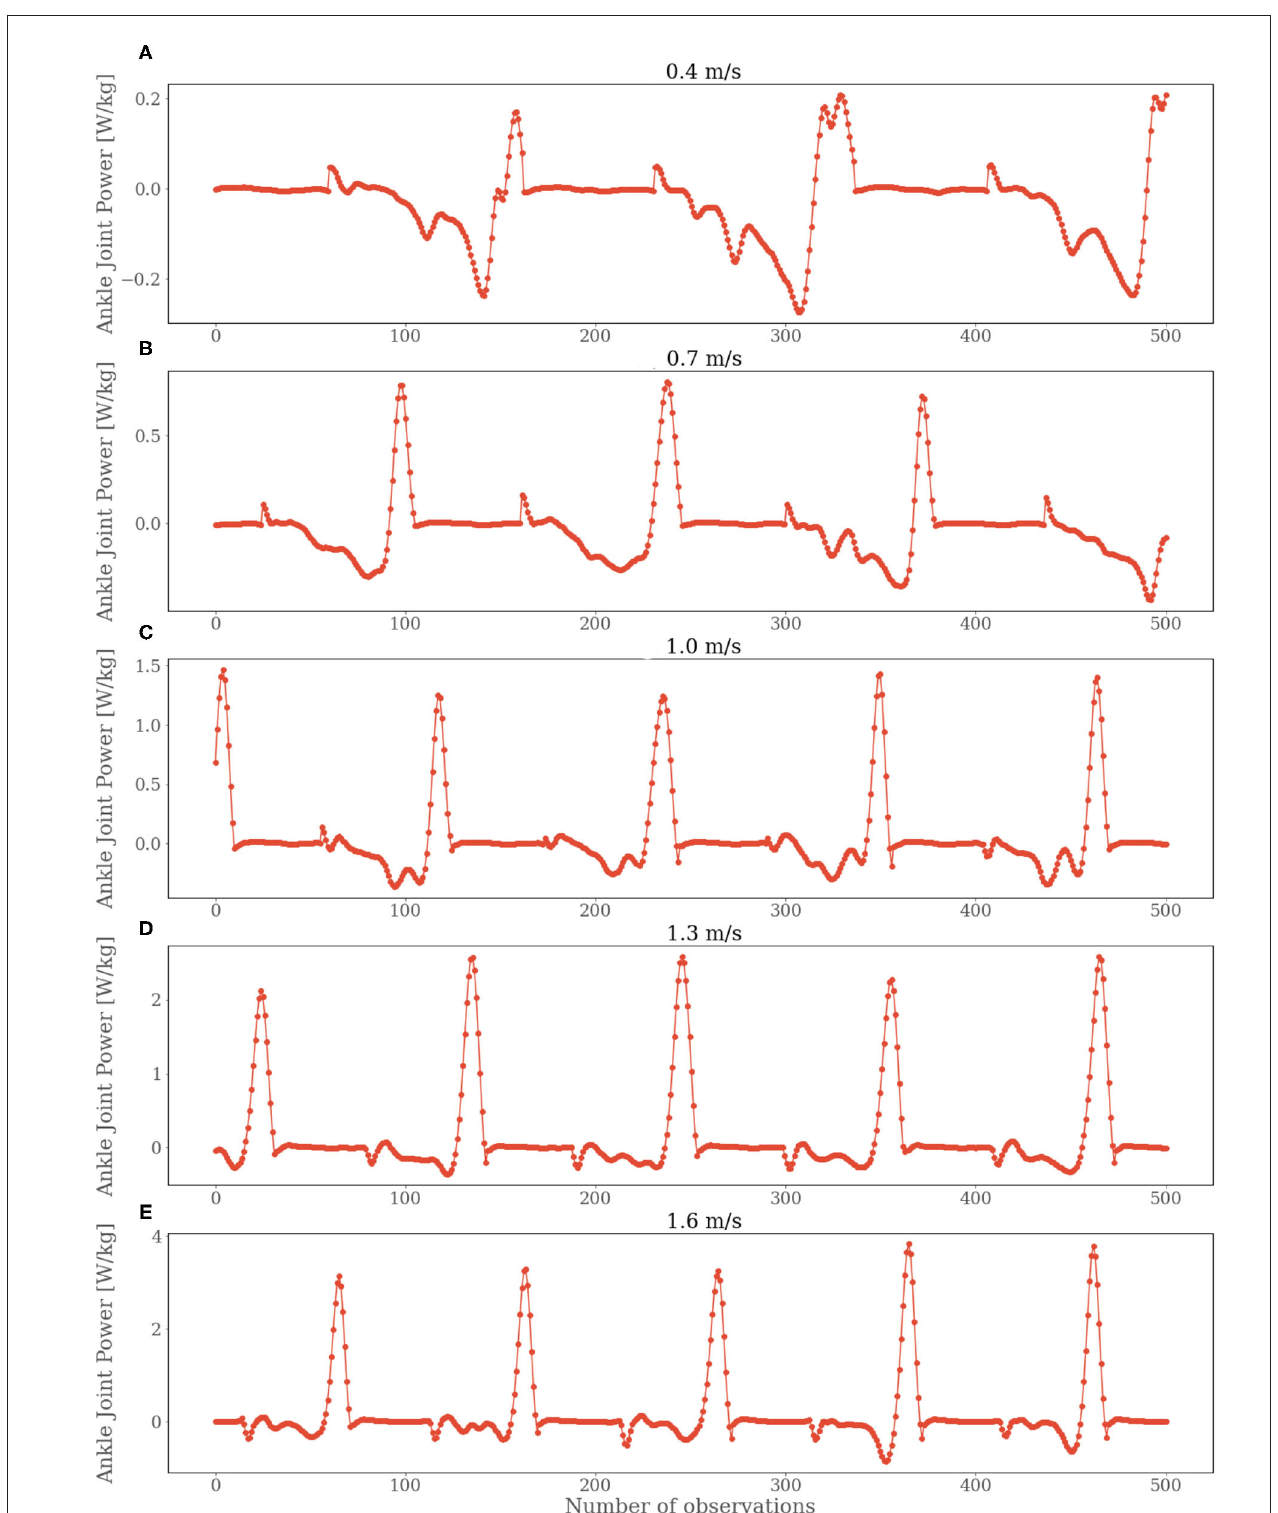
FIGURE 7 | Ankle joint power values for subject 2 for all the velocities. Starting from 0.4 m/s in (A) , 0.7 m/s in (B) , 1.0 m/s in (C) , 1.3 m/s in (D) and 1.6 m/s in (E) .